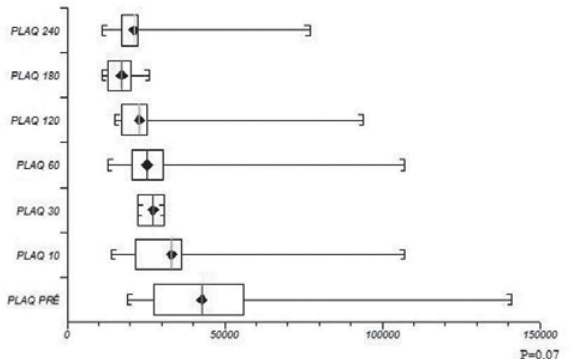
Fig. 5 – Dosagens de plaquetas (PLAQ) previamente e nos diferentes tempos da circulação extracorpórea